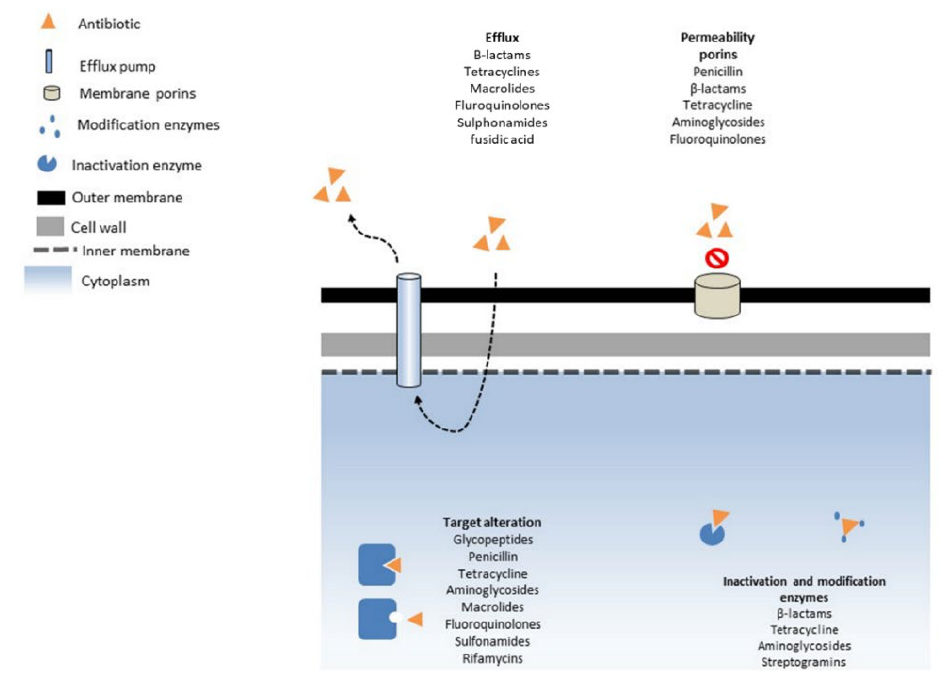
Figure 1. Mechanisms of antibiotic resistance in bacteria. Bacterial cell membrane barriers and membrane protein can prevent antibiotics uptake, or bacteria can reduce intracellular concentration by efflux pumps. Also, antibiotic targets can be modified to reduce affinity. Finally, some antibiotics can be deactivated by specialized enzymes like β -lactamases. Sometimes, several mechanisms of resistance act in concert to provide high-level resistance.